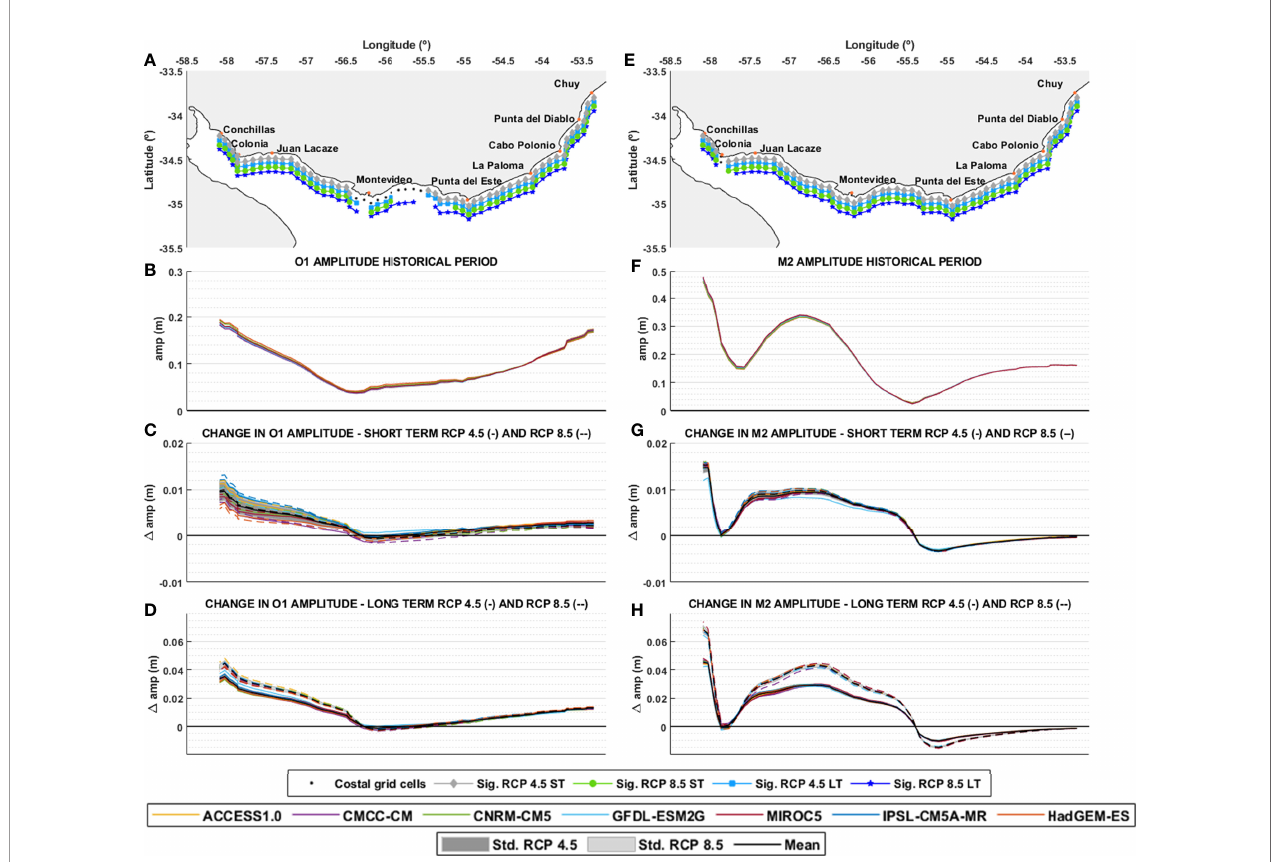
FIGURE 11 | Change in O1 component amplitude (A – D) and change in M2 component amplitude (B – H) obtained from local model forced with each GCM and ensemble (black), along the coast for short (2026-2045) and long term (2082-2100) and for RCP 4.5 (continuous lines) and RCP 8.5 (dotted lines). E.g.: change in M2 component for the short term is calculated as the difference between 2045-2026 M2 amplitude and 1986-2005 M2 amplitude. (A, E) coastal grid cells coastal grid cells and signi fi cance for the ensemble change for each scenario (the symbol indicates statistical signi fi cance of the ensemble change), (B, F) : component amplitude, (C, G) : change for short term, (D, H) : change for long